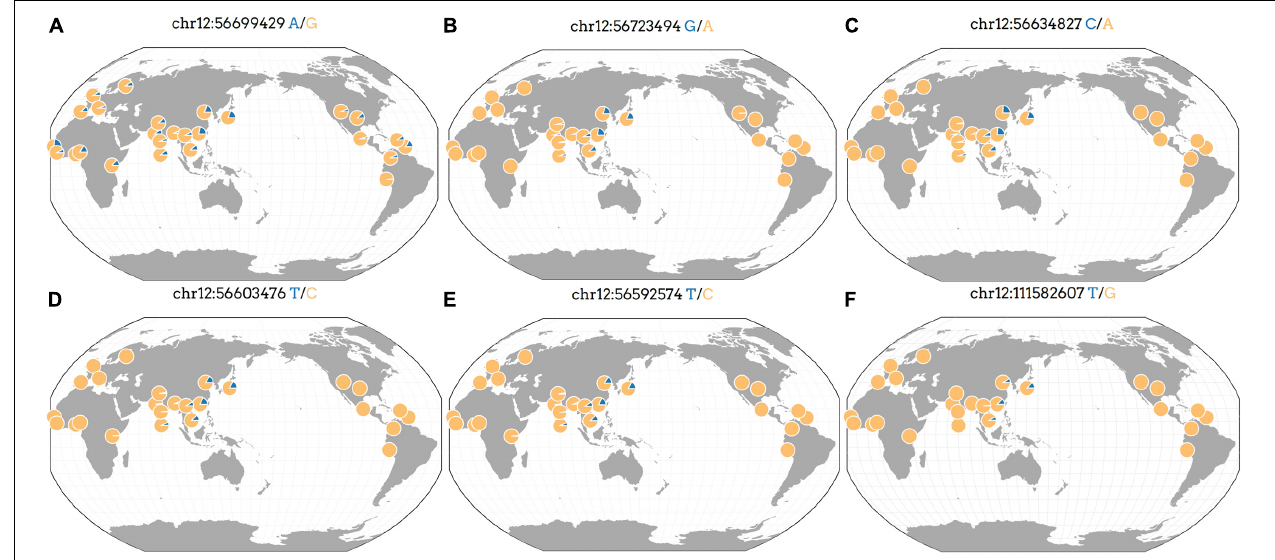
FIGURE 3 | Geographic distribution of Asian-specific variants identified as independent signals in previously reported genes. The position of the genetic variant is described at the top, and the blue part indicates an allele frequency based on 1,000 genomes (hg19). (A) rs7133285, (B) rs146426492, (C) rs72648137, (D) rs76280383, (E) rs76459740, and (F)